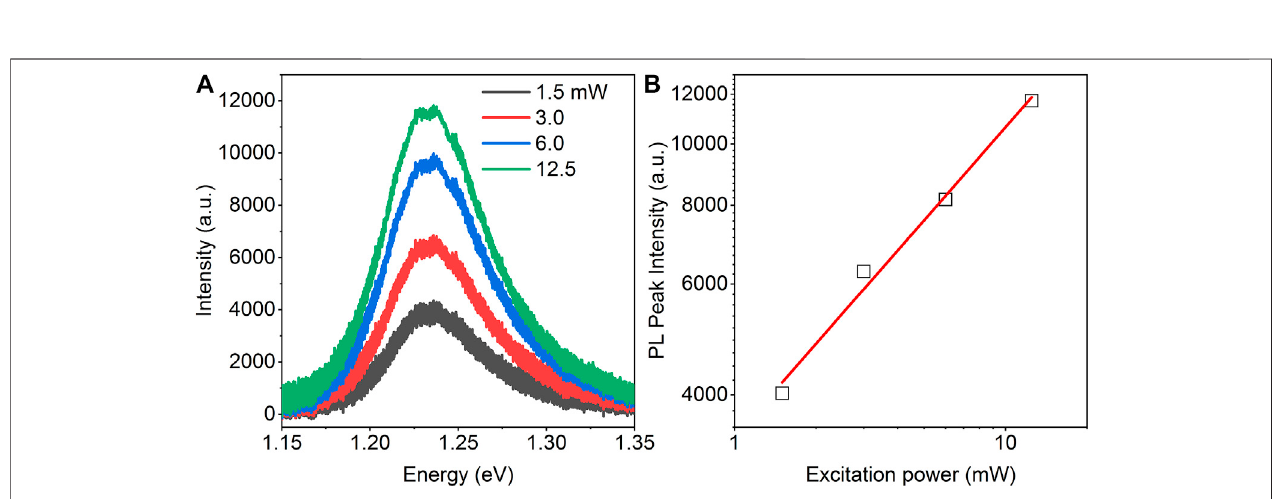
FIGURE 6 | (A) Photoluminescence (PL) spectra of the γ -InSe fl ake of about 22 nm at different incident laser power indicated. (B) Log – log plot of PL intensity as a function of the excitation power. The solid red line is the linear fi tting curve with power-law index of ∼